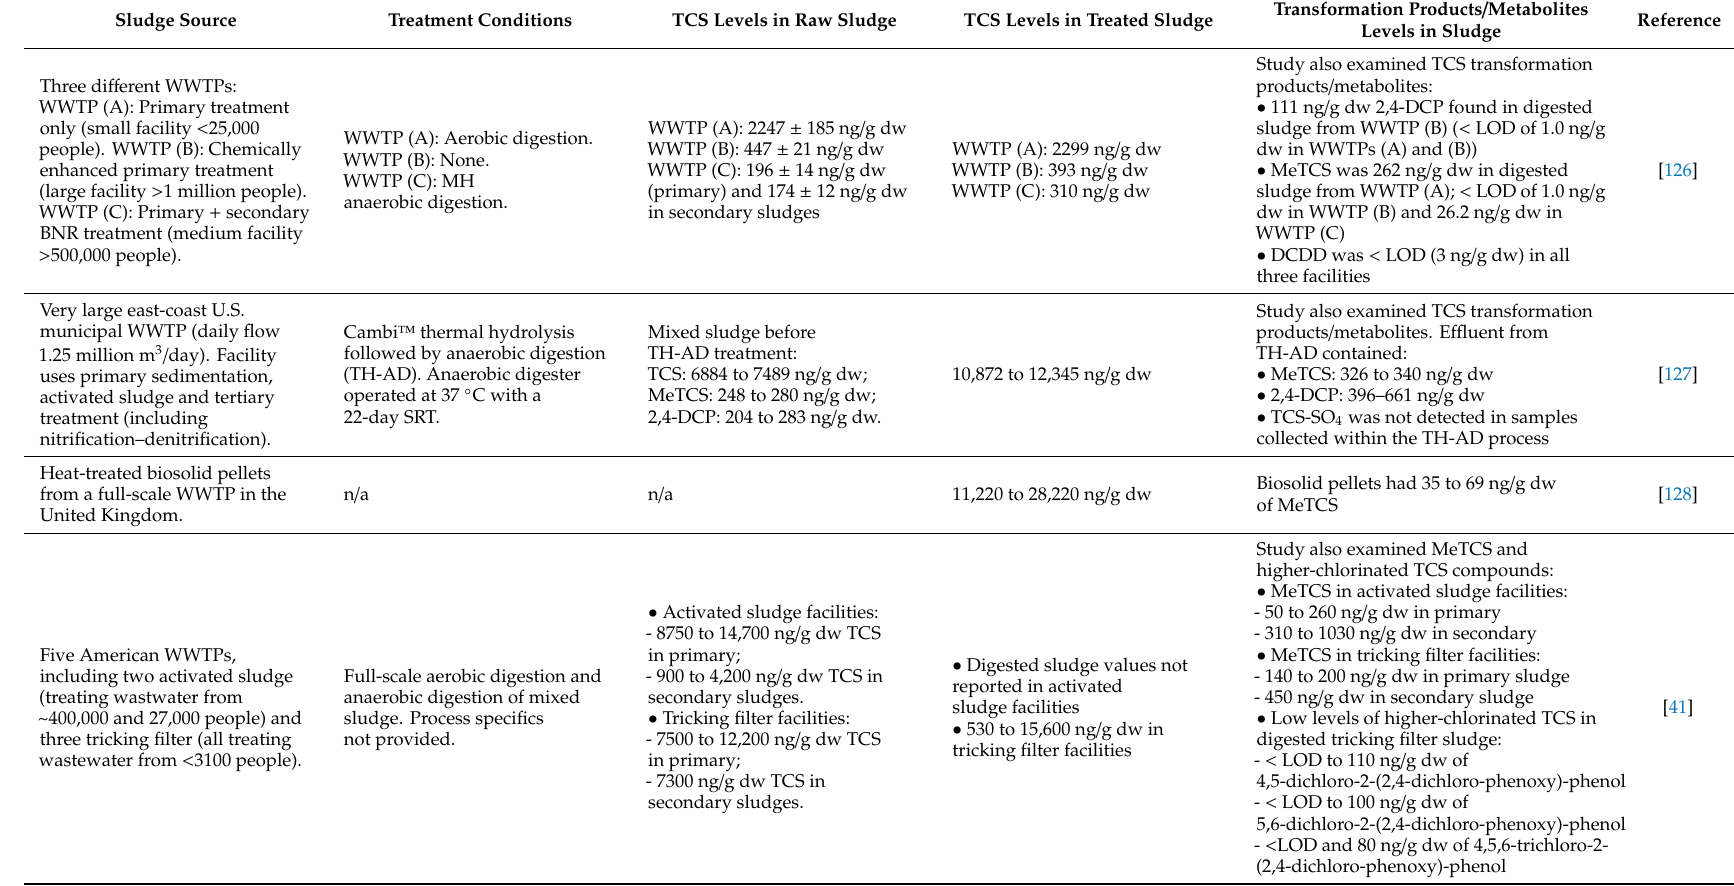
Table 2. Occurrences of triclosan and its transformation products / metabolites in sludge and